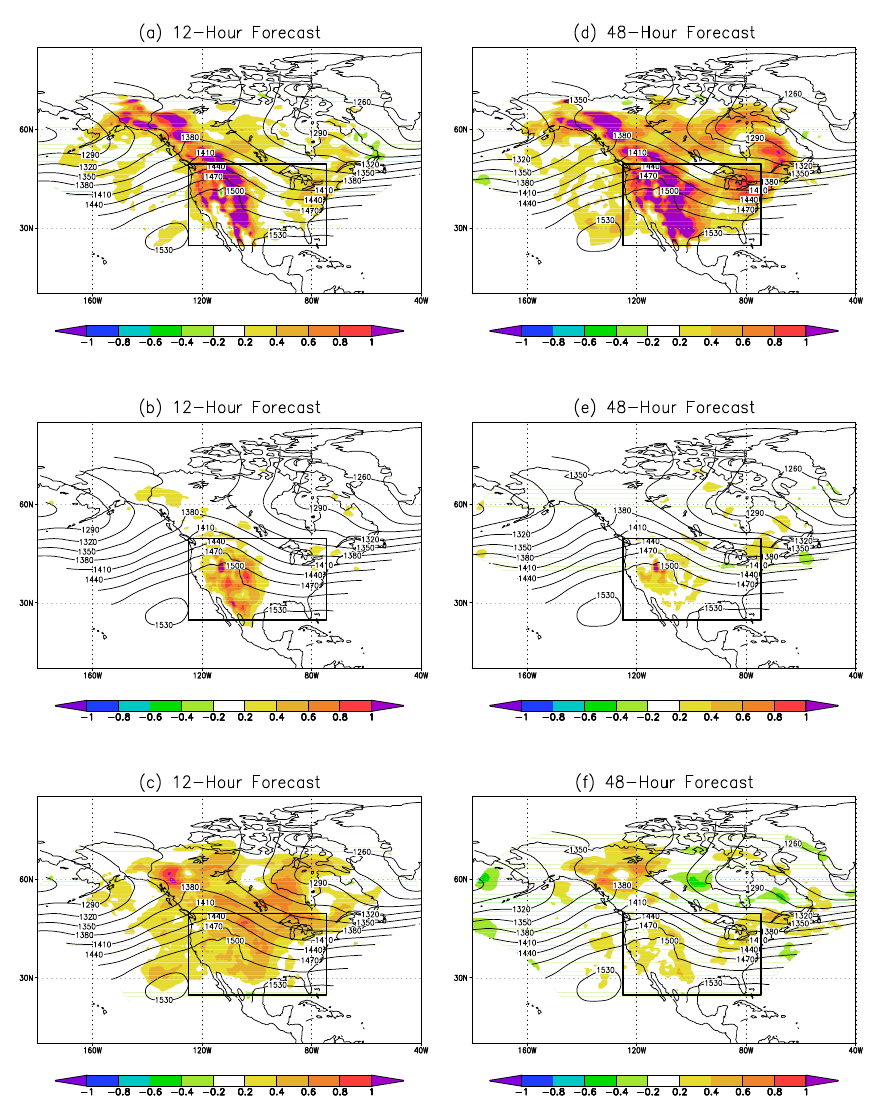
Fig. 8. Same as Fig. 6, except for the temperature at the 850hPa